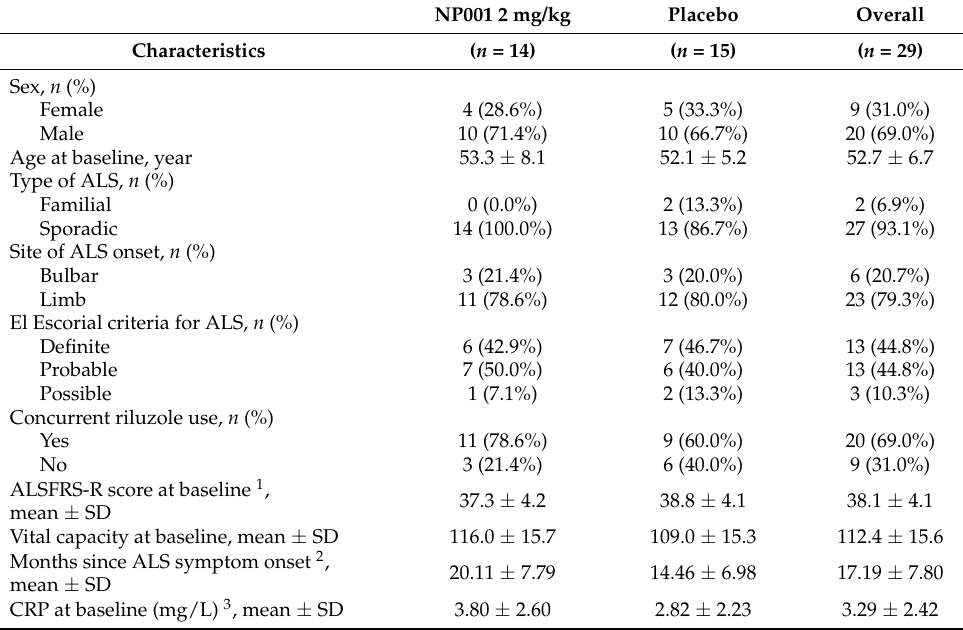
Table 2. Baseline demographics and characteristics of participants treated with NP001 vs. placebo in those with age between 40 and 65 years old and plasma CRP > 1.13 mg/L.